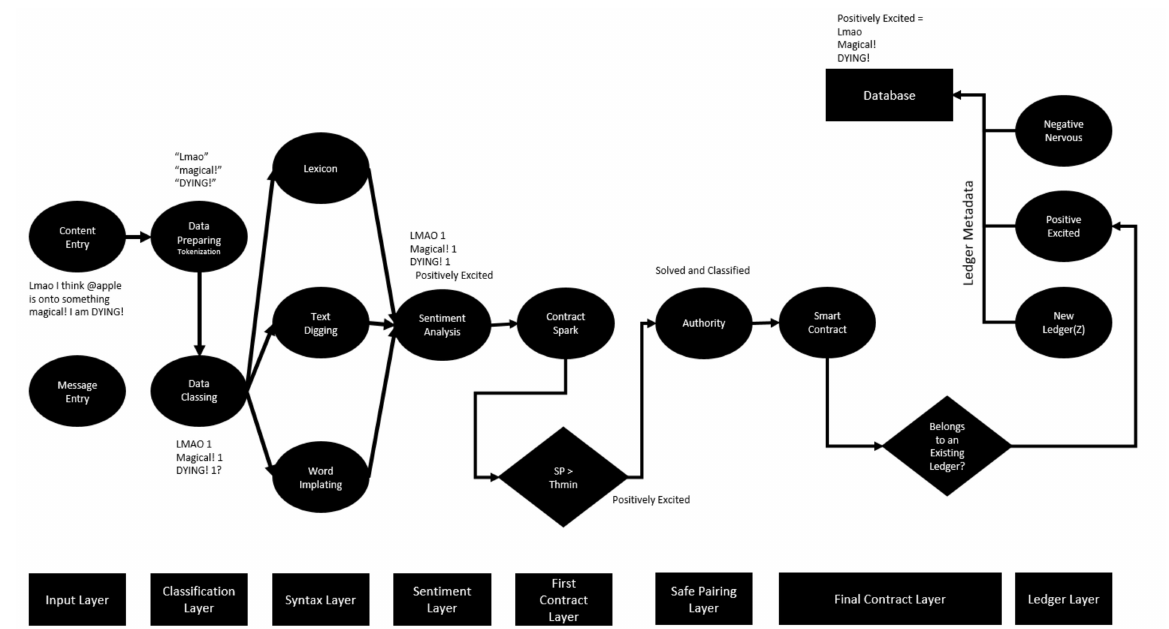
Figure 10. Random time, second least positive excited data flow chart.